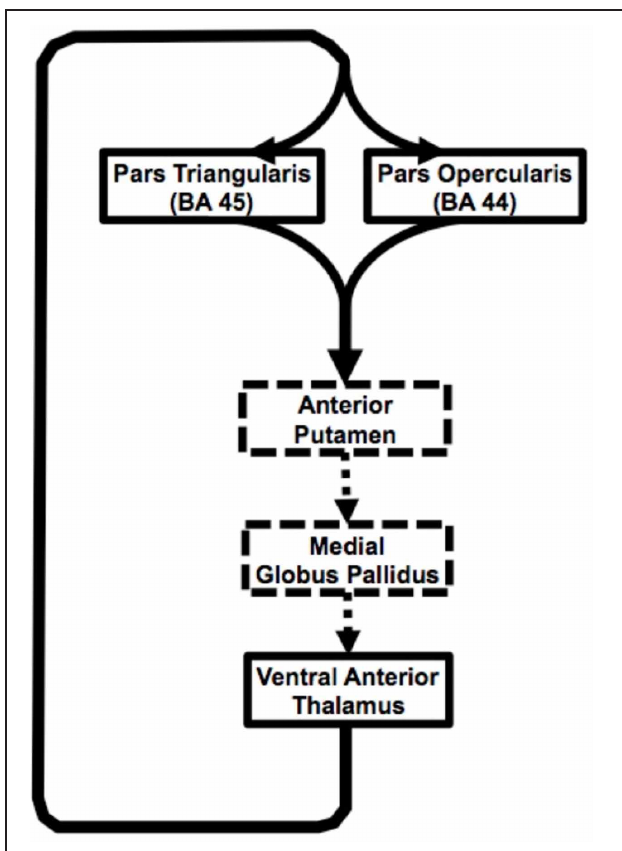
FIGURE 5 | Schematic representation of the Broca’s area basal ganglia loops. Solid black arrow represent pathways presented in our study, dashed arrows represent inferred based on other